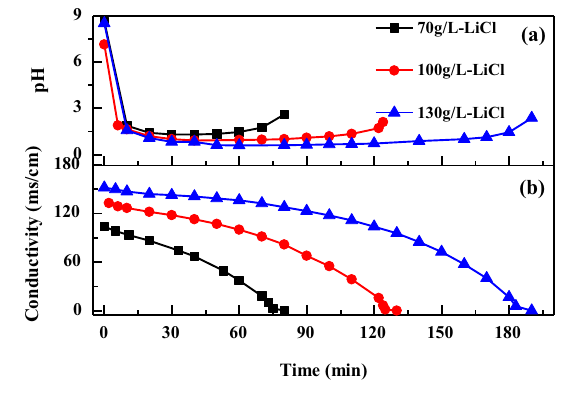
Fig. 5 Variation of the conductivity ( b ) and pH ( a ) with feed con-